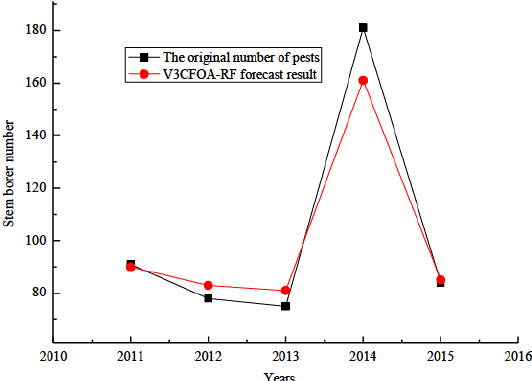
Figure 6: The prediction results of V3CFOA-RF borer based on the test